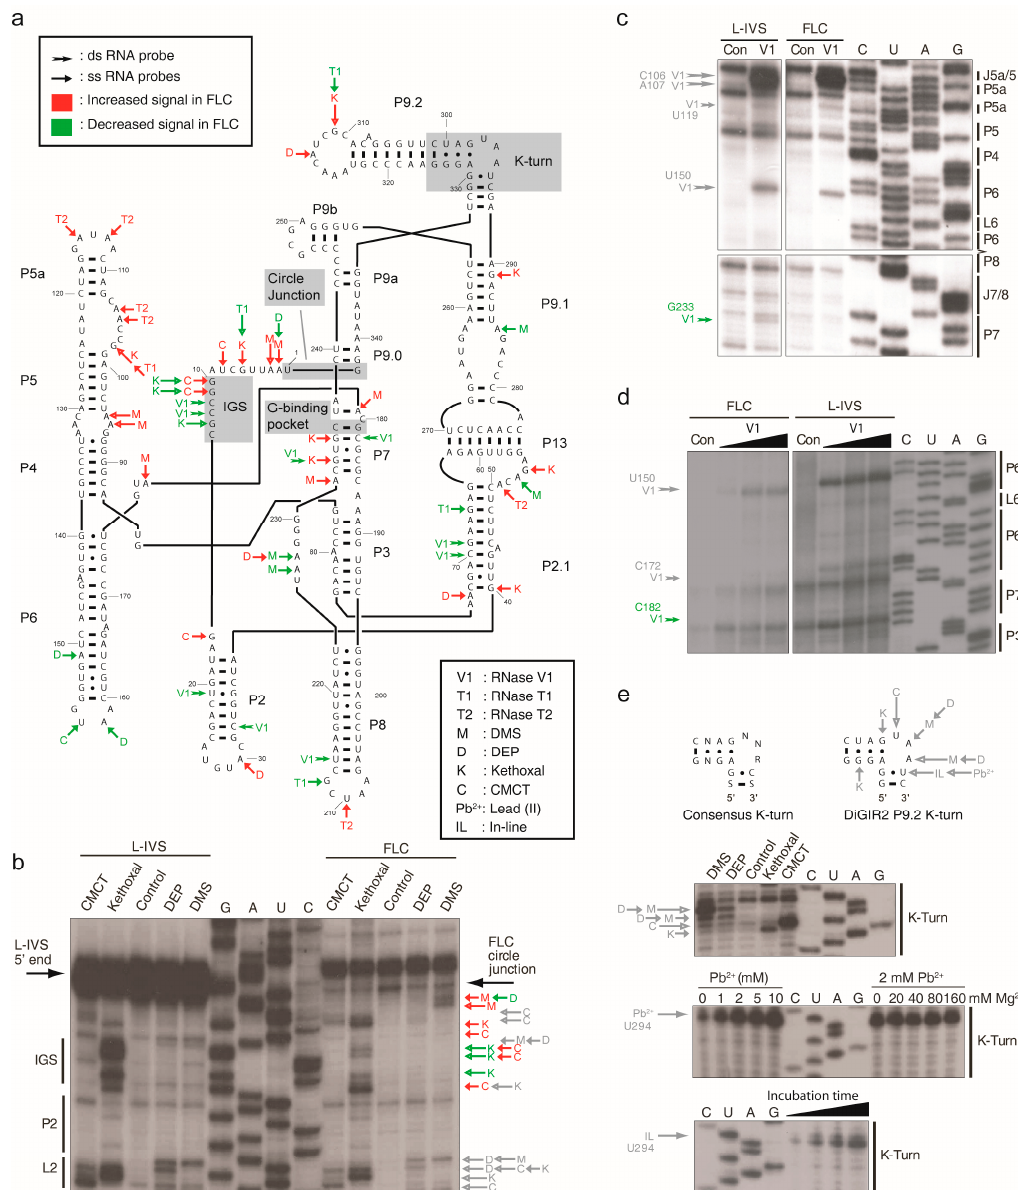
Figure 3. Compilation of probing results for DiGIR2 FLC and L-IVS. Differences in probing signals in FLC compared to L-IVS are highlighted. Red indicates increased signal in FLC, green decreased signal. Grey indicates signals that are similar in the two. The individual structure probing maps of FLC and L-IVS are depicted in Supplementary Materials Figure S2. In addition to the summary secondary structure diagram ( a ), examples of probing gels for the Internal Guide Sequence (IGS) ( b ), P7 comprising essential parts of the G-binding pocket ( c and d ), and the K-turn ( e ), are shown. The type of probe is indicated by letters next to the arrows (M: DMS, D: DEP, K: Kethoxal, C: CMCT, T1: RNase T1, T2: RNase T2, V1: RNase V1) and explained in the box in the central part of the figure. The length of the arrows reflects the signal strength. The paired segments are denoted P1–P13, and nucleotide positions within the DiGIR2 construct are indicated by numbers.